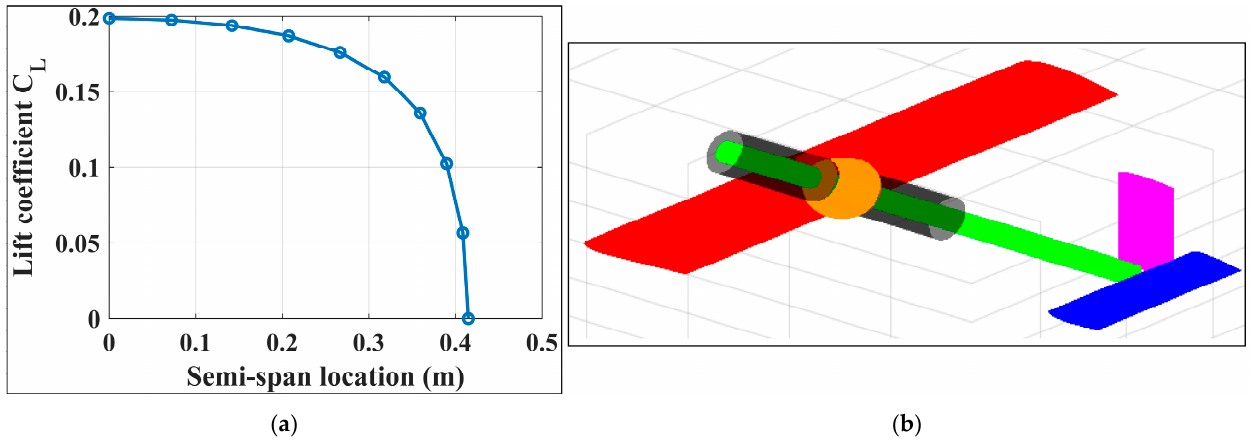
Figure 5. ( a ) Sample lift distribution on MM3’s horizontal tail, and ( b ) Center of gravity display .